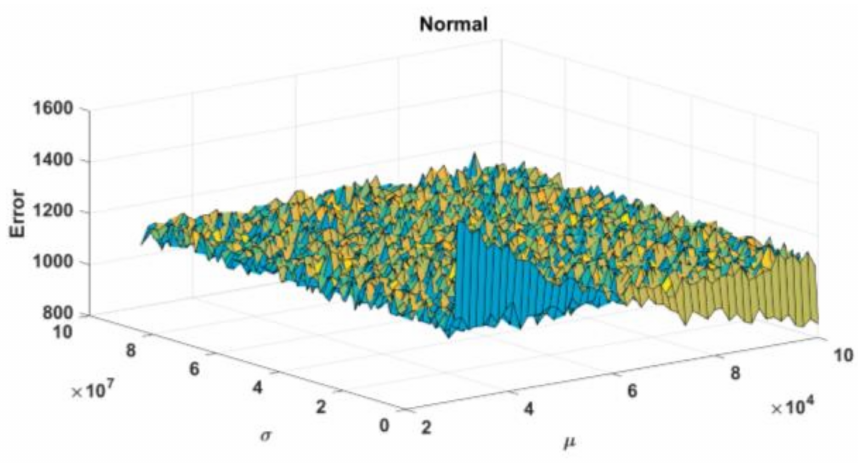
Figure 15. Validation error (Normal): Error—error value, σ —sample variance, µ —sample mathemat- ical expectation.